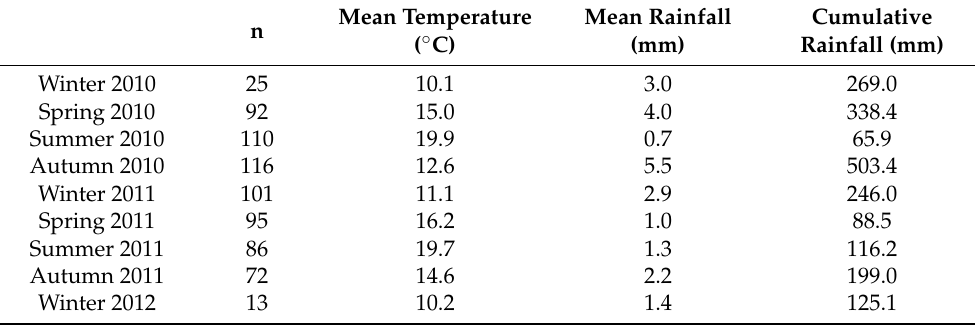
Table 3. Number of Microtus lusitanicus analysed (n) and seasonal values of climate variables corresponding to the year prior to host